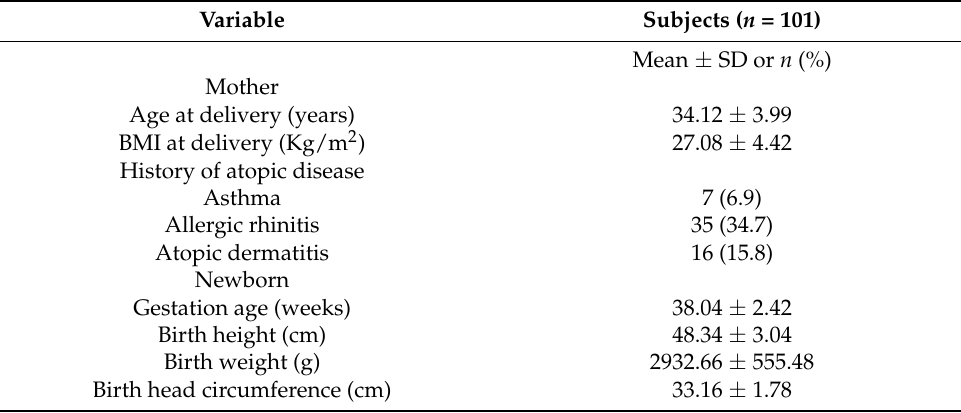
Table 1. Demographic characteristics of the participant mothers and their